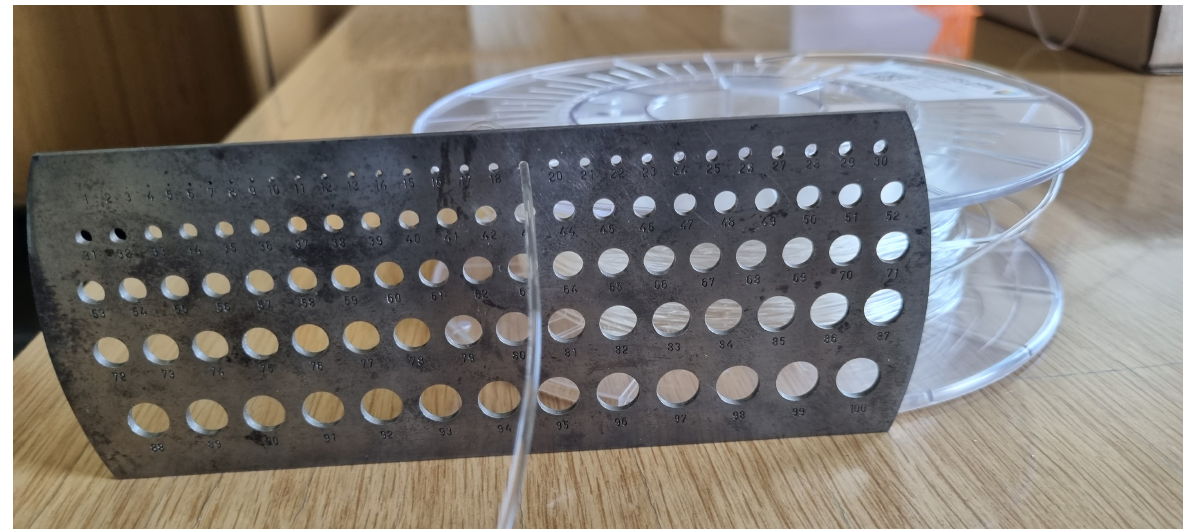
Figure 12. Although the filament diameter is measured and regulated during filament production between fixed values of 1.65 mm to 1.85 mm via cross-axis laser micrometer, see Figures 5 and 6, it is additionally verified and re-structured. The example shows pure PLA material A (Luminy L130), which is pulled through the borehole number 19 with a 1.9 mm diameter for high quality 3D printing filaments with a final nominal value of 1.75 mm. This quality verification step becomes especially important for self(reinforced) PLA, as the inner-core may stick out or surface distortions can occur due to core/shell/sheath